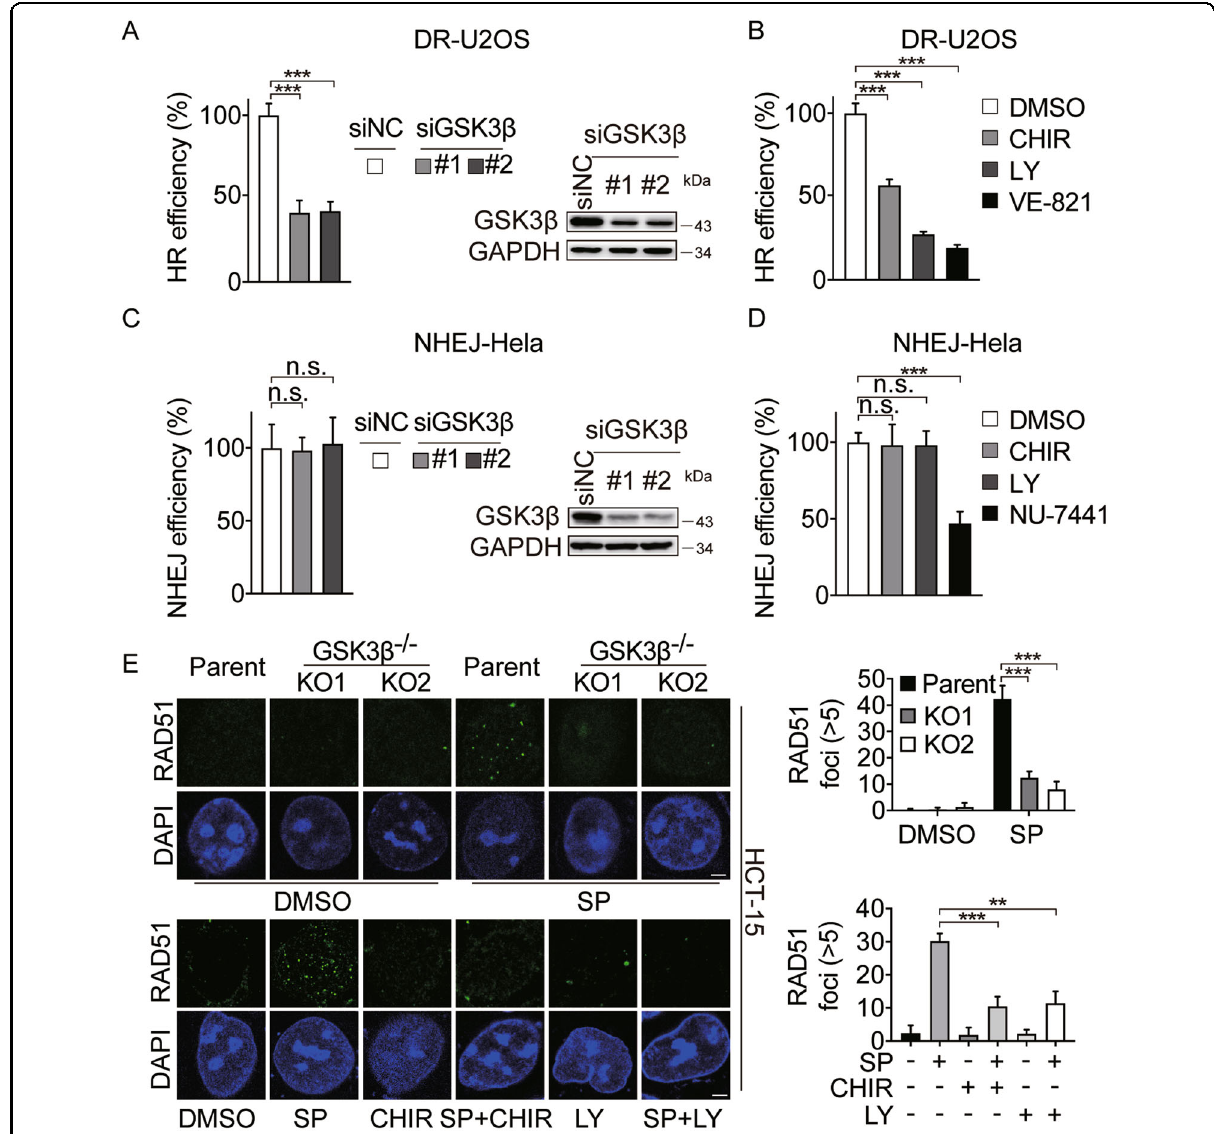
Fig. 5 GSK3 β is required for the homologous recombination repair of DSBs. A – D DR-U2OS ( A and B ) or NHEJ – Hela ( C and D ) cells were treated with siRNA, GSK3 β inhibition (5 μ M CHIR99021 HCl or 5 μ M LY2090314), or positive control of VE-821 (5 μ M, in HR assays) or NU-7441 (10 μ M, in NHEJ assays) for 24 h, followed by I-SceI transfection. GFP-positive cells were analyzed by fl ow cytometry 48 h later. Data are expressed as mean ± SD from three independent experiments. (*** p < 0.001, n.s. not signi fi cant, t test). CHIR, CHIR99021 HCl; LY, LY2090314. E Representative images of RAD51 foci in HCT-15 (parent) and their GSK3 β -depleted single clone (KO1 and KO2) cells treated with 5 μ M simmiparib (Upper) or HCT-15 cells following treatment with 5 μ M simmiparib, GSK3i (10 μ M CHIR99021 HCl or 5 μ M LY2090314), or a combination for 48 h (Lower). Nuclei were stained with DAPI. Scale bar: 2 μ m. Cells that contained fi ve or more RAD51 foci/nucleus were considered as RAD51-positive cells. At least 50 cells were analyzed for each experiment and condition. All data are expressed as mean ± SD from three independent experiments. (** p < 0.01, *** p < 0.001, t test). SP, simmiparib; CHIR, CHIR99021 HCl; LY,